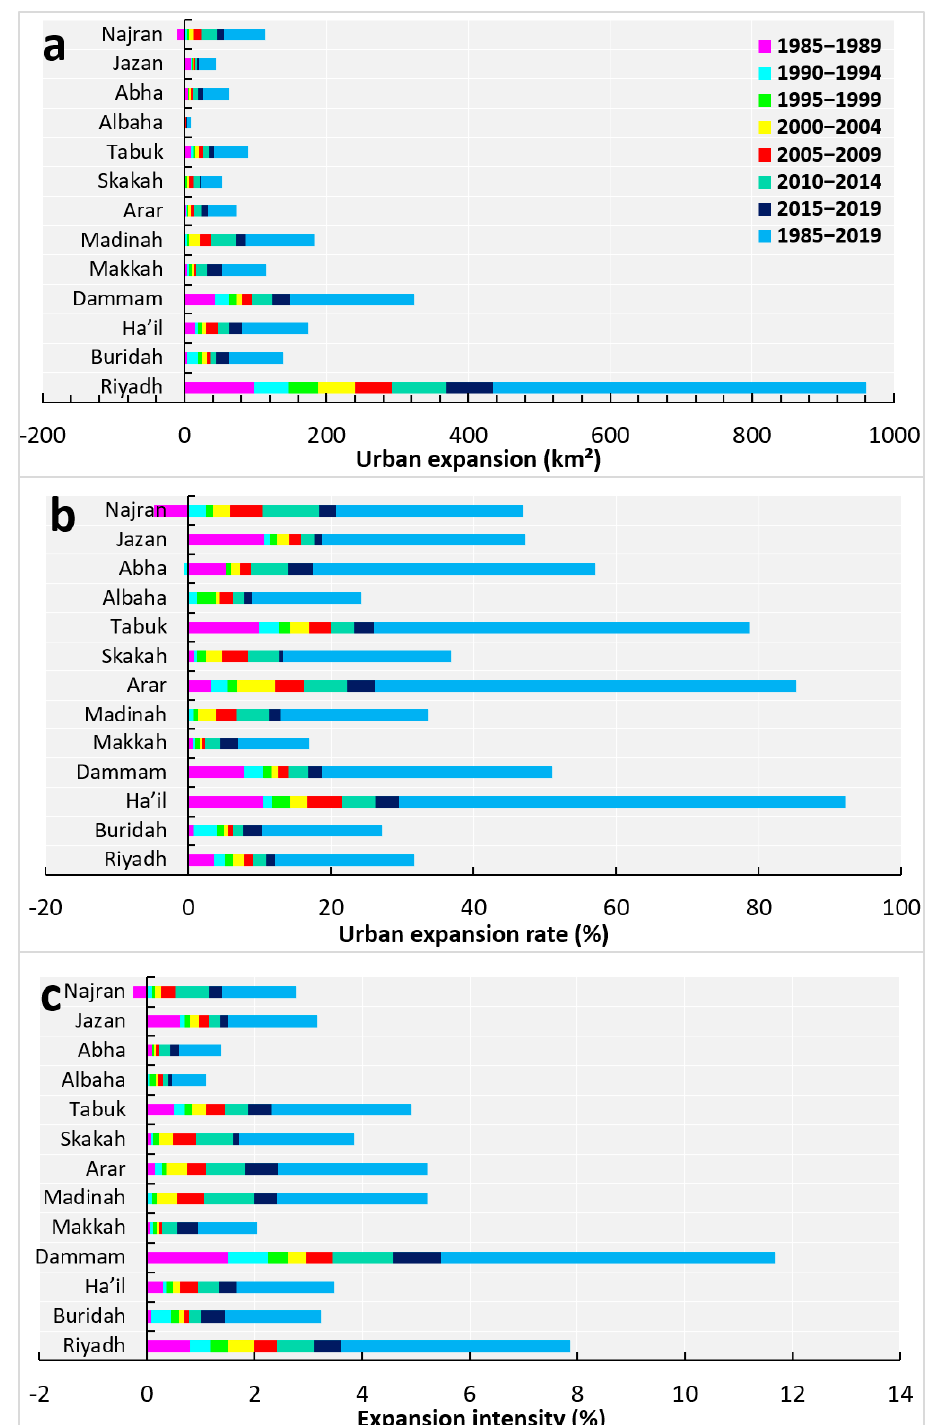
Figure 8. Three urban indices of the 13 capital cities (1985–2019): ( a ) urban expansion (km 2 ), ( b ) urban expansion rate (%), and ( c ) expansion intensity (%). expansion rate (%), and ( c ) expansion intensity